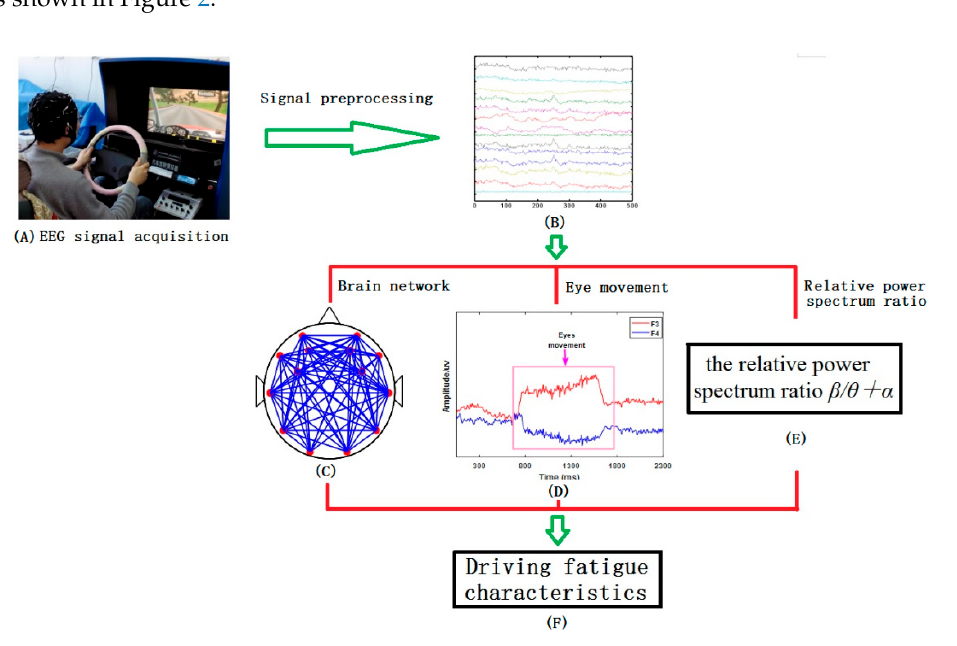
Figure 2. ( A ) EEG signal acquisition; ( B ) 14 channels of original signals collected; ( C ) Building brain network; ( D ) Analysis of eye movement signal characteristics; ( E ) Calculate the relative power spectrum ratio β / θ + α ; ( F ) Analysis of Driving Fatigue Characteristics.